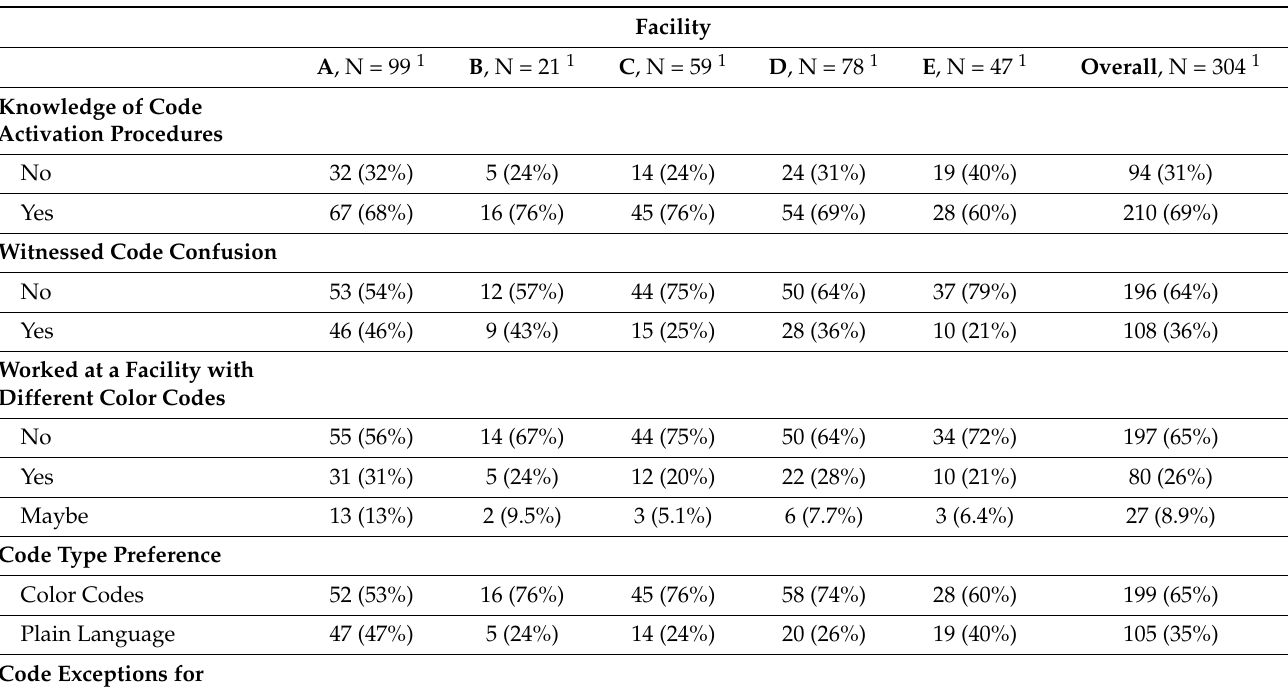
Table 2. Survey participant experience with emergency